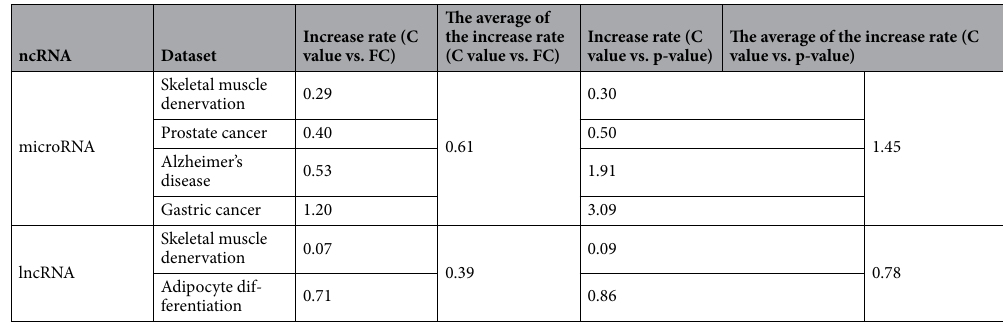
Table 6. Efficiency comparison of C value in IPA canonical pathways.